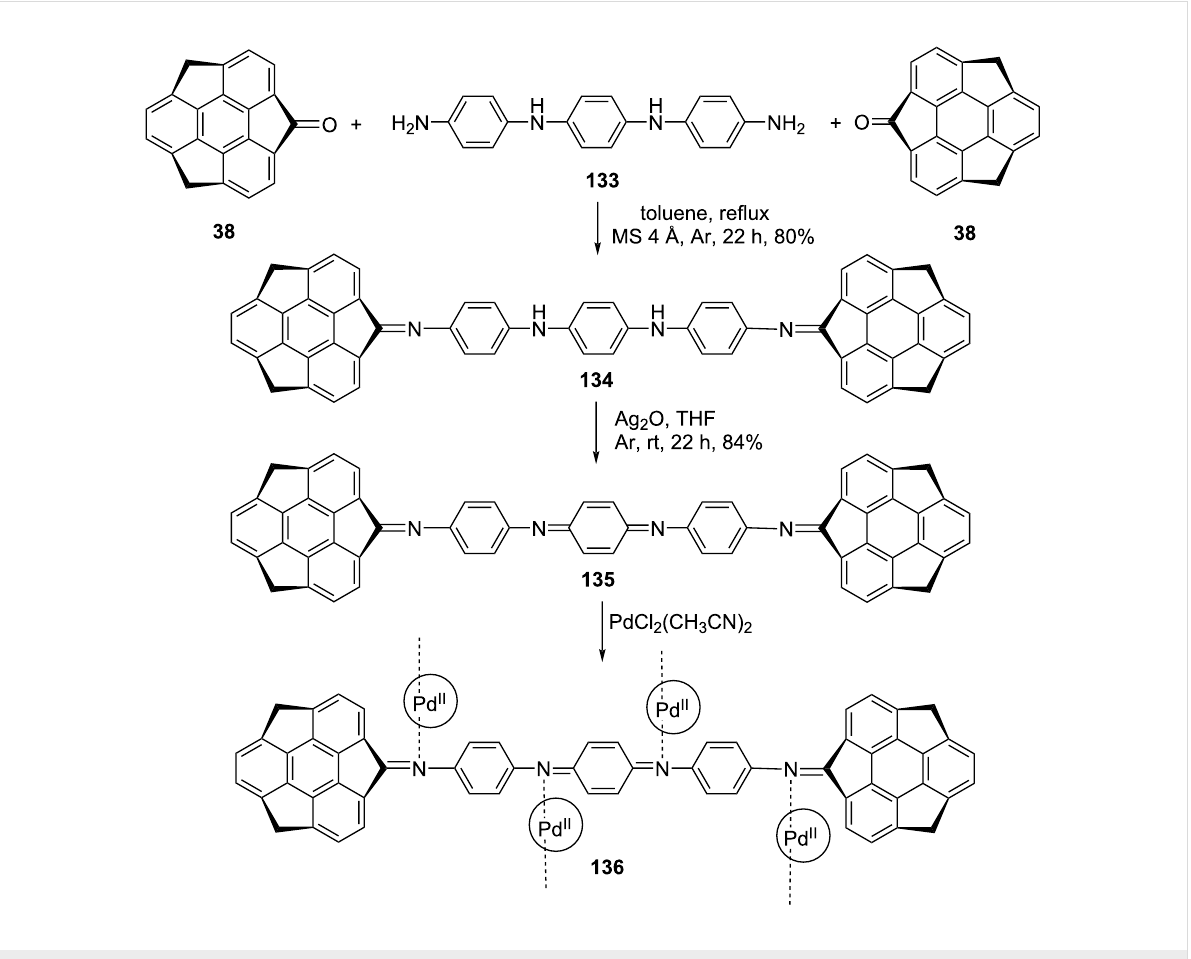
Scheme 35: Synthesis of 134 and 135 along with Pd II coordination complex 136 .